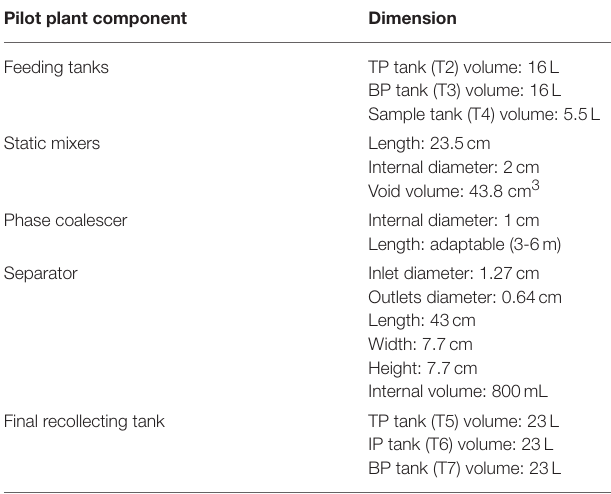
TABLE 1 | Dimensions of the scaled-up prototype components.